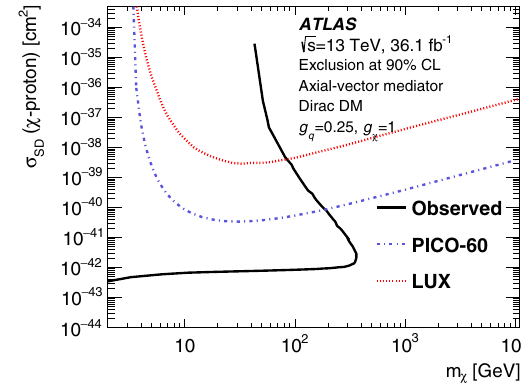
Fig. 5 The 90% CL exclusion limit on the χ –proton scattering cross section in a simplified model of dark-matter production involving an axial-vector operator, Dirac DM and couplings g q = 0 . 25 , g χ = 1 and g (cid:14) = 0 as a function of the dark-matter mass m χ . Also shown are results at 90% CL from two direct dark-matter search experiments [78,79] ( left ). The 90% CL exclusion limit on the χ –nucleon scattering